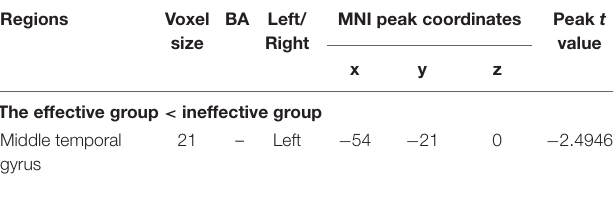
TABLE 6 | | Brain regions with different functional connectivity between the responsive and unresponsive groups. Regions Voxel BA Left/ size Right